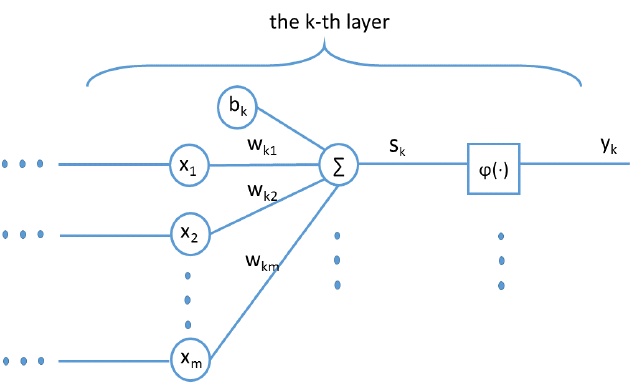
Figure 4. An illustration of perceptron